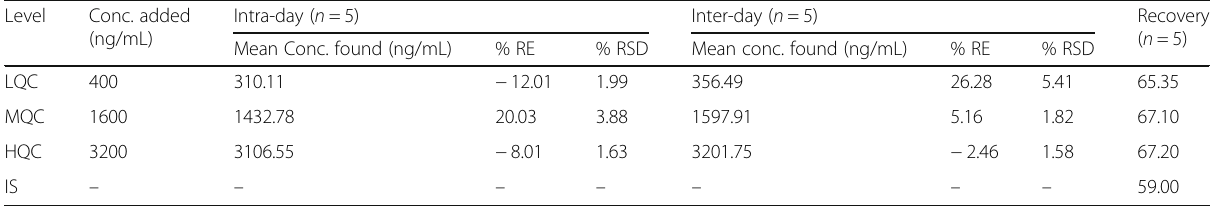
Table 5 Results of accuracy and precision studies